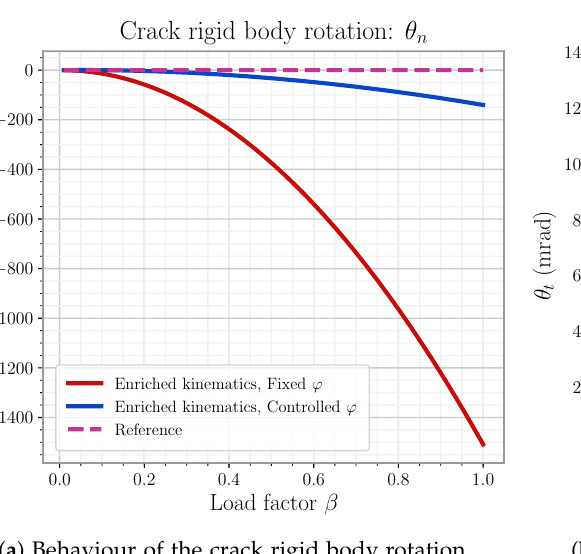
] n u , ( b ) and ( c ) as parallel sliding [ 0 | |